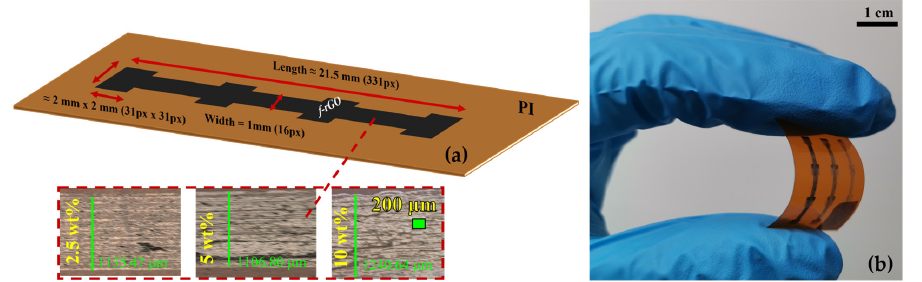
Figure 1. ( a ) Test line structure geometries and top view details from optical microscope for various ink concentrations; ( b ) fabricated devices with a single and multipass approach.